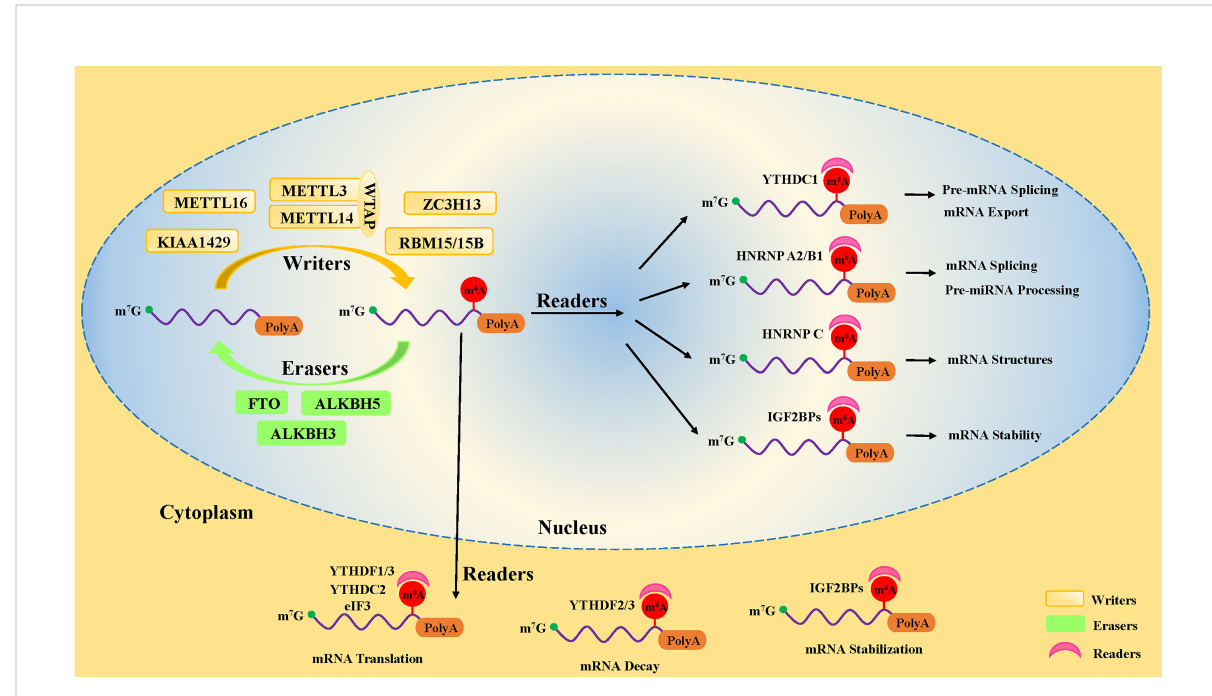
FIGURE 1 The dynamic process of m6A methylation in mRNA. The m 6 A methylation is installed by methyltransferases ( “ writers ” ), including METTL3, METTL14, WTAP, METTL16, ZC3H13, RBM15/15B, and KIAA1429. It is removed by demethylases ( “ Erasers ” ), including FTO, ALKBH5, and